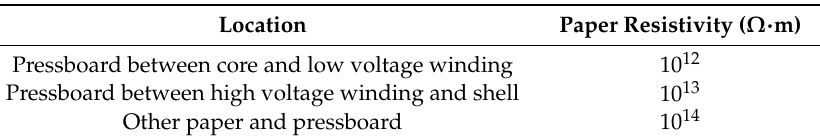
Table 2. Setting of paper resistivity values.